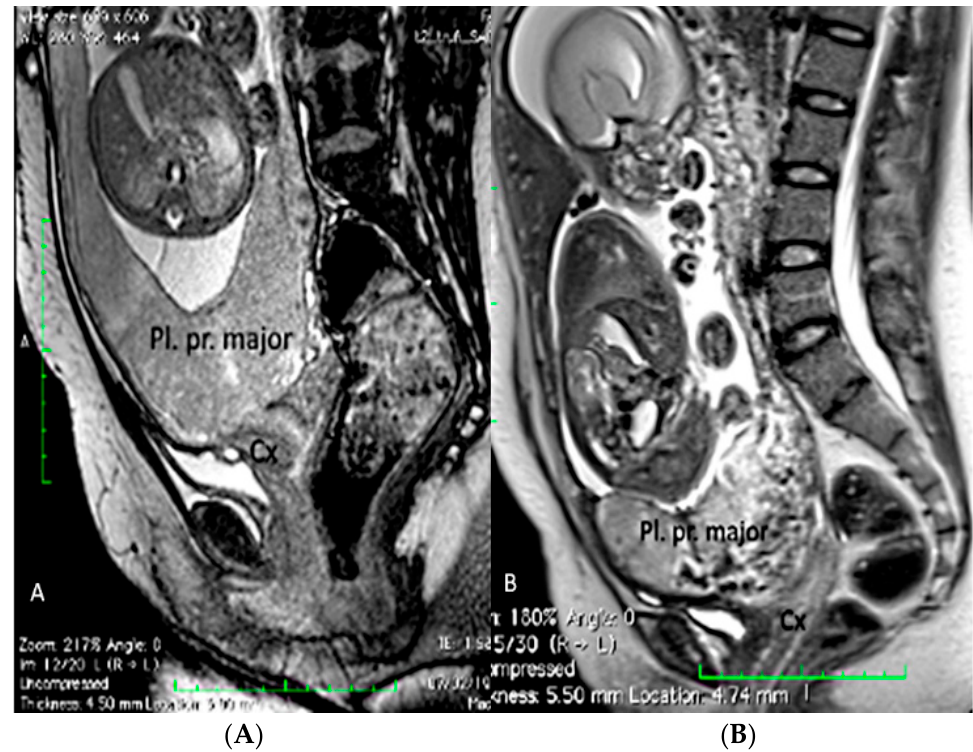
Figure 4. Fetal MRI (sagittal T2) performed at 30 weeks and 26 week’s gestation in two different fetuses ( A , B ), demonstrating a placenta praevia major and accretism. (Legend: Pl: placenta; Cx: cervix) .